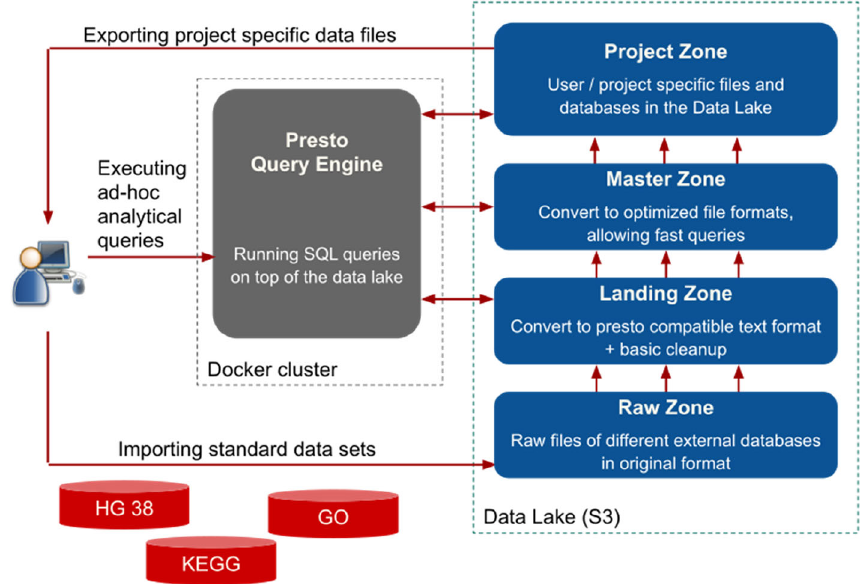
Figure 2. A schematic representation of the relationship between Sherlock's two main components: the Query Engine (dockerized) and the Data Lake. Left side: The core component of the platform: the Presto Query Engine. It allows the user to execute different analytical SQL queries on top of the data files in the Data Lake (right side). Right side: The structure of our Data Lake. They are separated into four different zones. Working from bottom to top; 1) The Raw Zone contains the raw data from the different external or bespoke databases in their original formats. 2) The landing Zone, where the data is in JSON Lines format, is compatible with the Presto Query Engine. 3) The master zone, where the data is in a common optimized and compressed format, is called ORC. This format enables faster query execution than the landing zone. 4) The Project Zone, where we store exclusively the data needed for specific/active